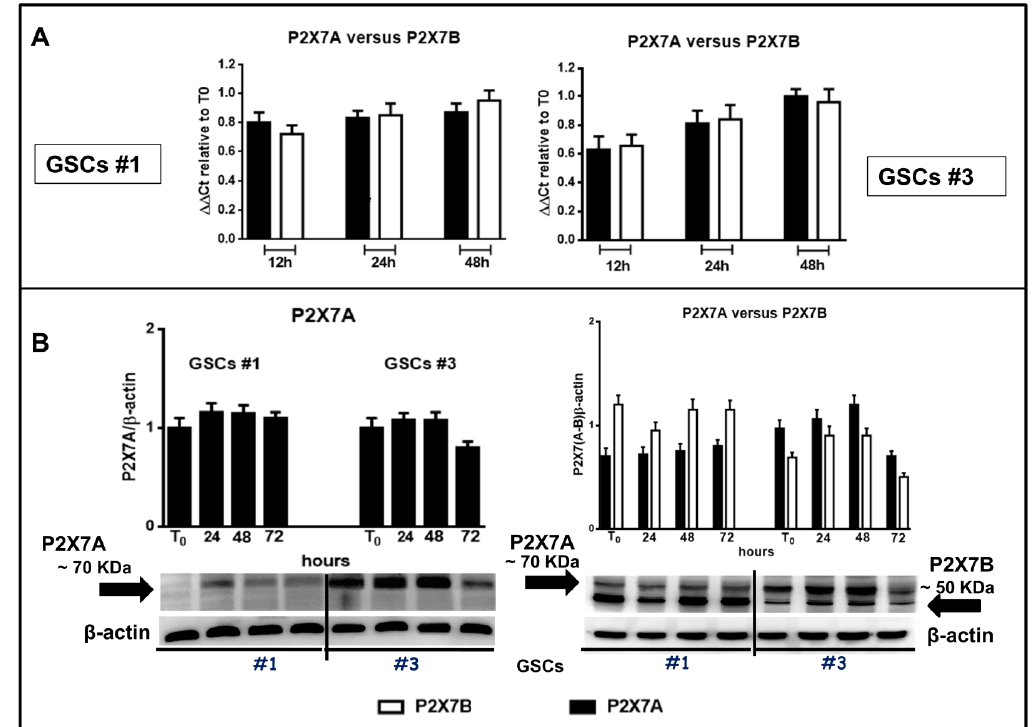
Figure 11. Expression of the two main human splice variants P2X7R A and B in GSCs. Confluent GSCs were harvested at di ff erent time periods to obtain their mRNA or proteins. ( A ) by qRT-PCR the evaluation of the mRNA levels was performed in relation to the principal P2X7R splice variants in humans that are the full-length form P2X7A and the truncated form (lacking the carboxy-terminal tail) P2X7B in GSCs #1 and #3 (panels on left or right, respectively). mRNA levels were normalized by using the house keeping β 2-microglobulin as endogenous control. Values, calculated as fold of increase vs. those measured in cells at the beginning of the experiments (time 0) are the mean ± S.E.M. of 3 independent experiments performed using the cells above mentioned. Each sample was tested in duplicate. ( B ) protein levels of P2X7A and P2X7B monomers were determined by western blot analysis. Immunoblots were obtained by exposing membranes to two polyclonal antibodies, one recognizing among the others proteins at about 70 KDa and the second one recognizing proteins at about 70 and 50 KDa, respectively. Subsequently, immunoblots were re-probed with an antibody against β actin, to verify equal sample loading, and quantified by densitometric analysis. These values were then normalized to β actin and reported as such as for the histograms related to blots in which both P2X7R A and B subunits were recognized, whereas for the blots related to the only P2X7AR subunit the value were calculated assuming the ratio (cells at T 0 ) / β -actin = 1. All values are the mean ± SEM of three independent experiments for each cell type.